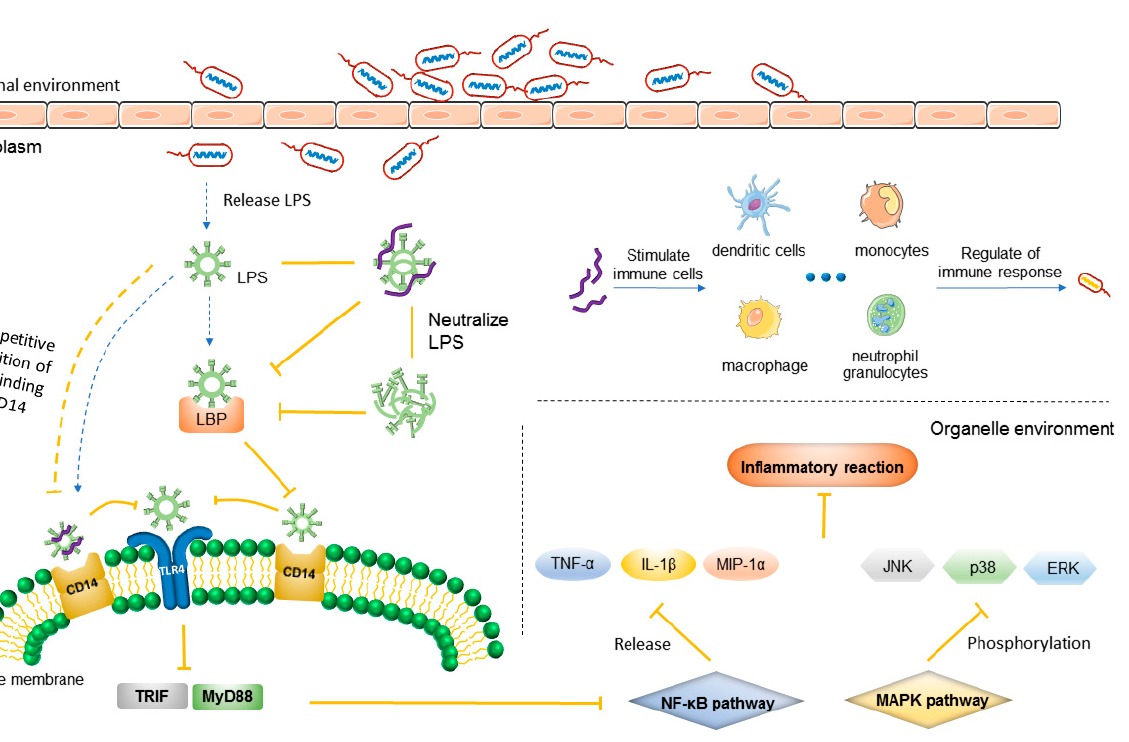
Figure 3. Anti-inflammatory mechanism of AMPs. It mainly refers to the inflammatory reaction caused by LPS. AMPs can inhibit inflammatory pathways (neutralizing LPS, inhibiting the binding of LPS and LBP, competitively inhibiting the binding of LPS and CD14, and inhibiting the release of immune factors), and regulate the immune function of immune cells.